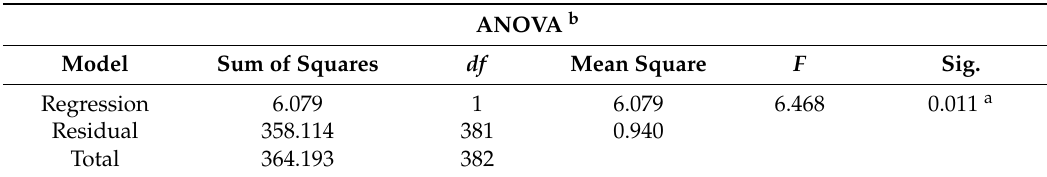
Table 6. ANOVA for unprovided information resources and library visit.